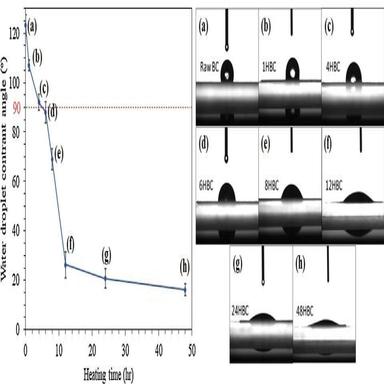
Water droplet contact angle with (a) raw BC, and HBCs heated at 300 C for (b) 1 h, (c) 4 h, (d) 6 h, (e) 8 h, (f) 12 h, (g) 24 h, and (h) 48 h. Dotted line shows 90 angle as the border between the hydrophobicity and hydrophilicity.